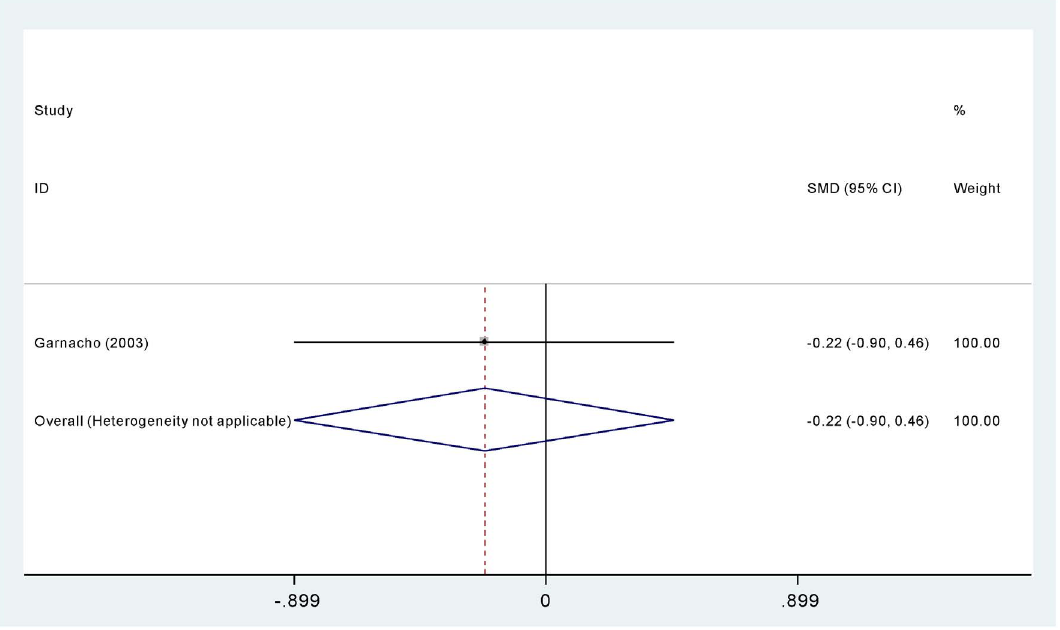
Figure 4. The efficacy and safety of polymyxins monotherapy compared with combination treatment in Acinectobacterbaumannii infection.